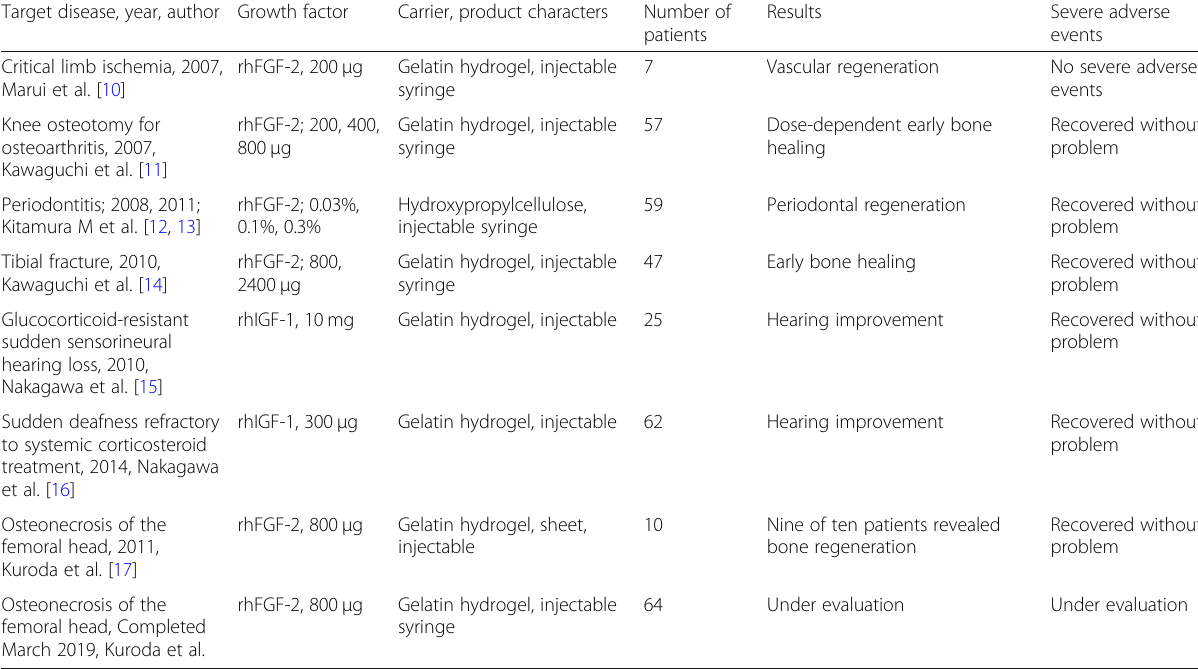
Table 1 Clinical trials using injectable growth factor Target disease, year, author Growth factor Carrier, product characters Number of